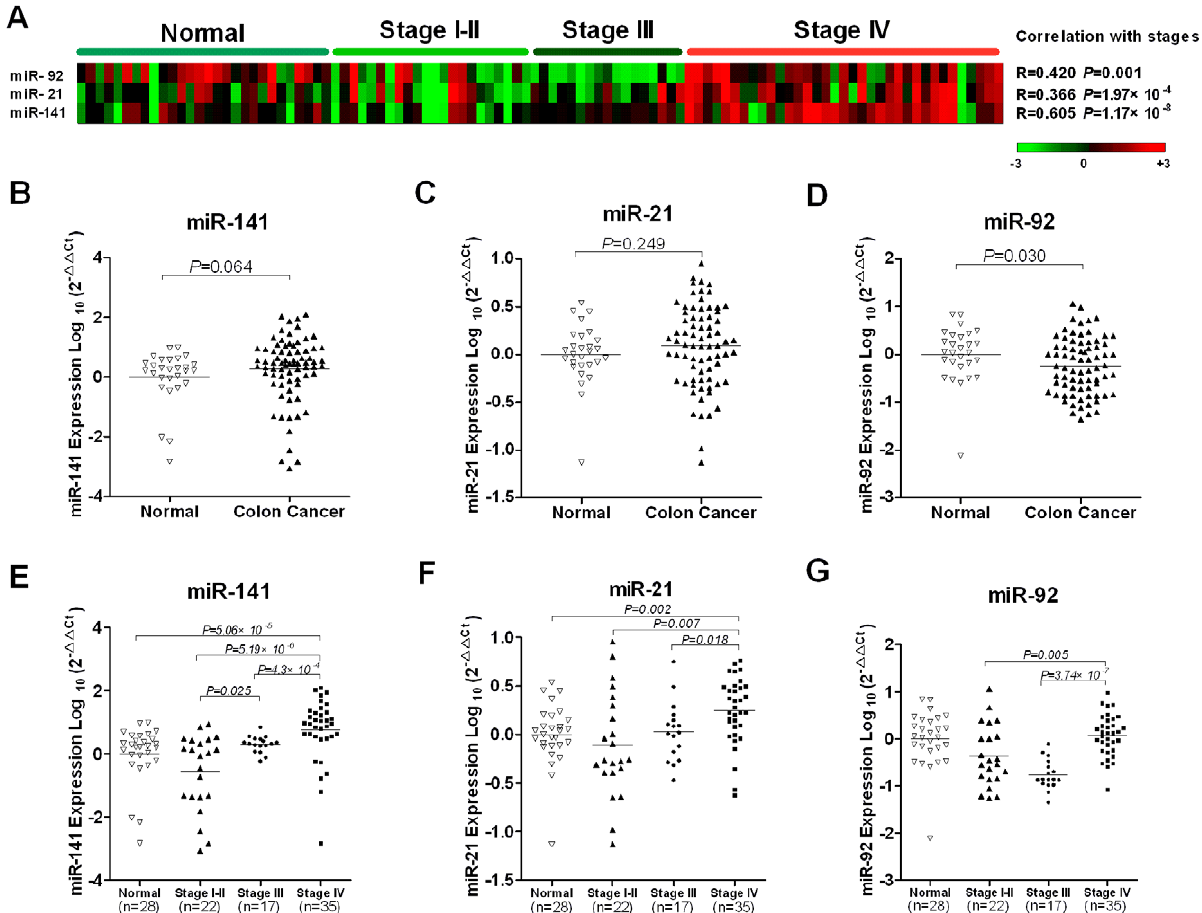
Figure 1. Plasma miR-141, miR-21 and miR-92 levels in healthy controls and colon cancer patients. (A) Each row corresponds to a plasma miRNA and each column corresponds to each sample. Expression levels for each miRNA are normalized across the samples and shaded in colors such that red denotes high expression and green denotes low expression. Spearman correlation shows that miR-141 is highly correlated with stages (r=0.605, P=1.17 6 10 2 8 ). (B–G) The relative levels of selected plasma microRNAs were normalized to spike-in control cel-miR-39 and shown as the log10 of the relative quantity (RQ). The Wilcoxon two-sample tests were performed to examine the difference of selected plasma microRNAs between normal controls and colon cancer patients (B–D), or between normal controls and/or colon cancer patients with different clinical stages (E–G).